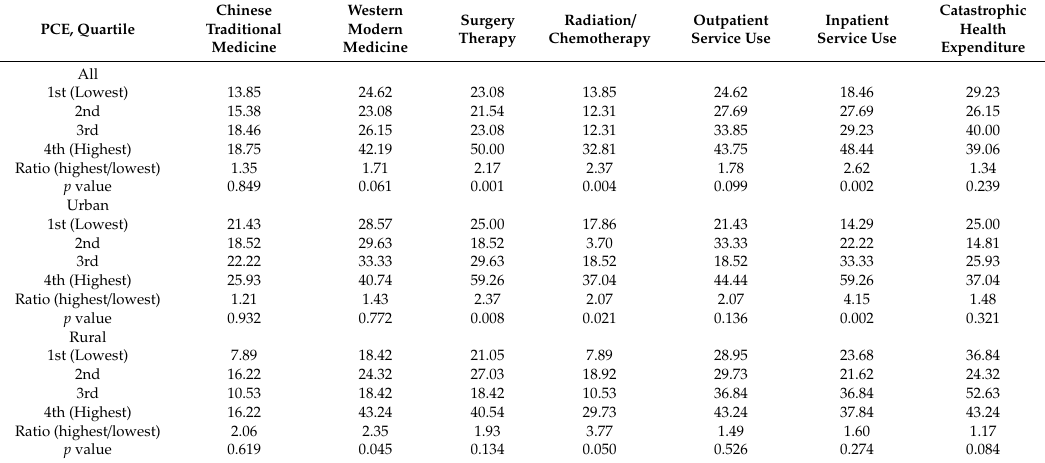
Table 3. Healthcare services and catastrophic health expenditure for cancer patients in China across wealth quarters, 2015